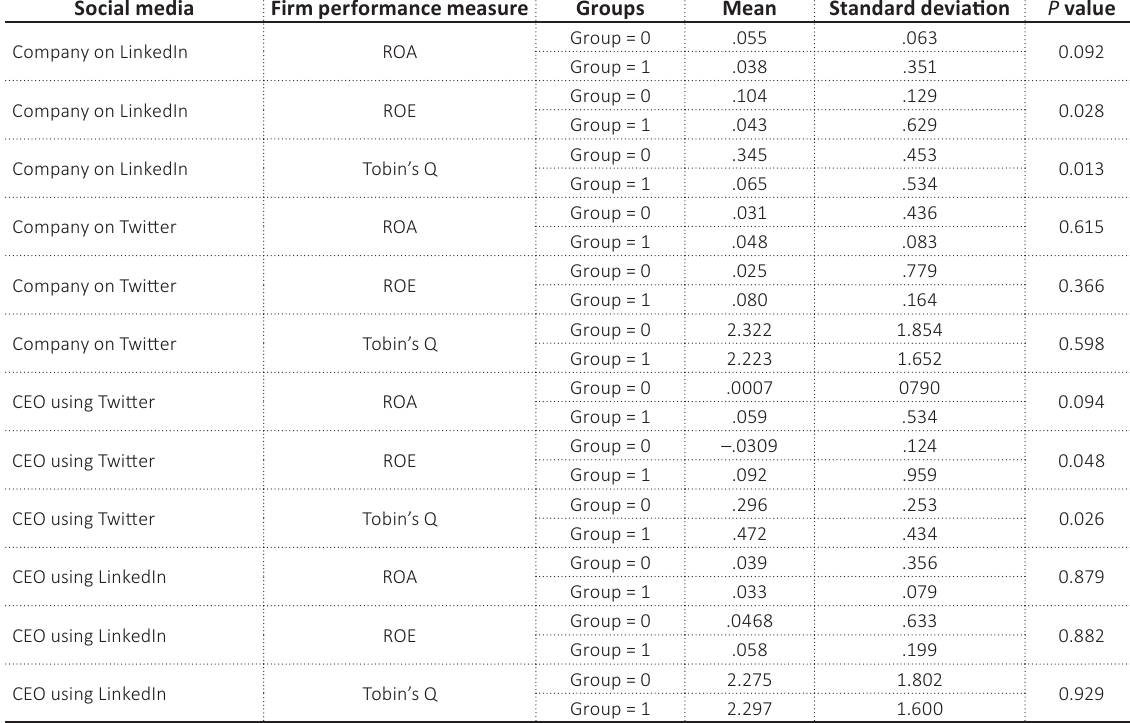
Table 3. Firms’ performance based on the social media usage